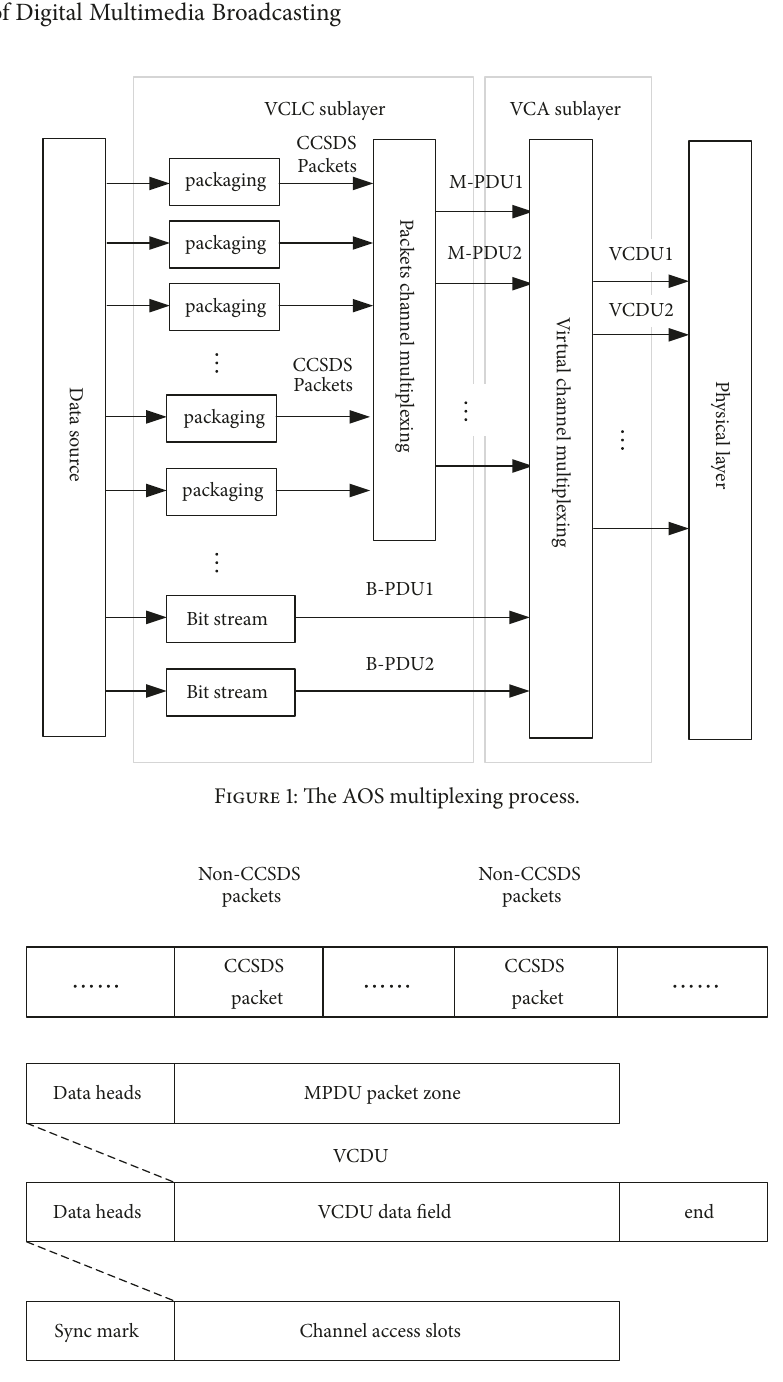
Figure 2: Transformation of data structure of